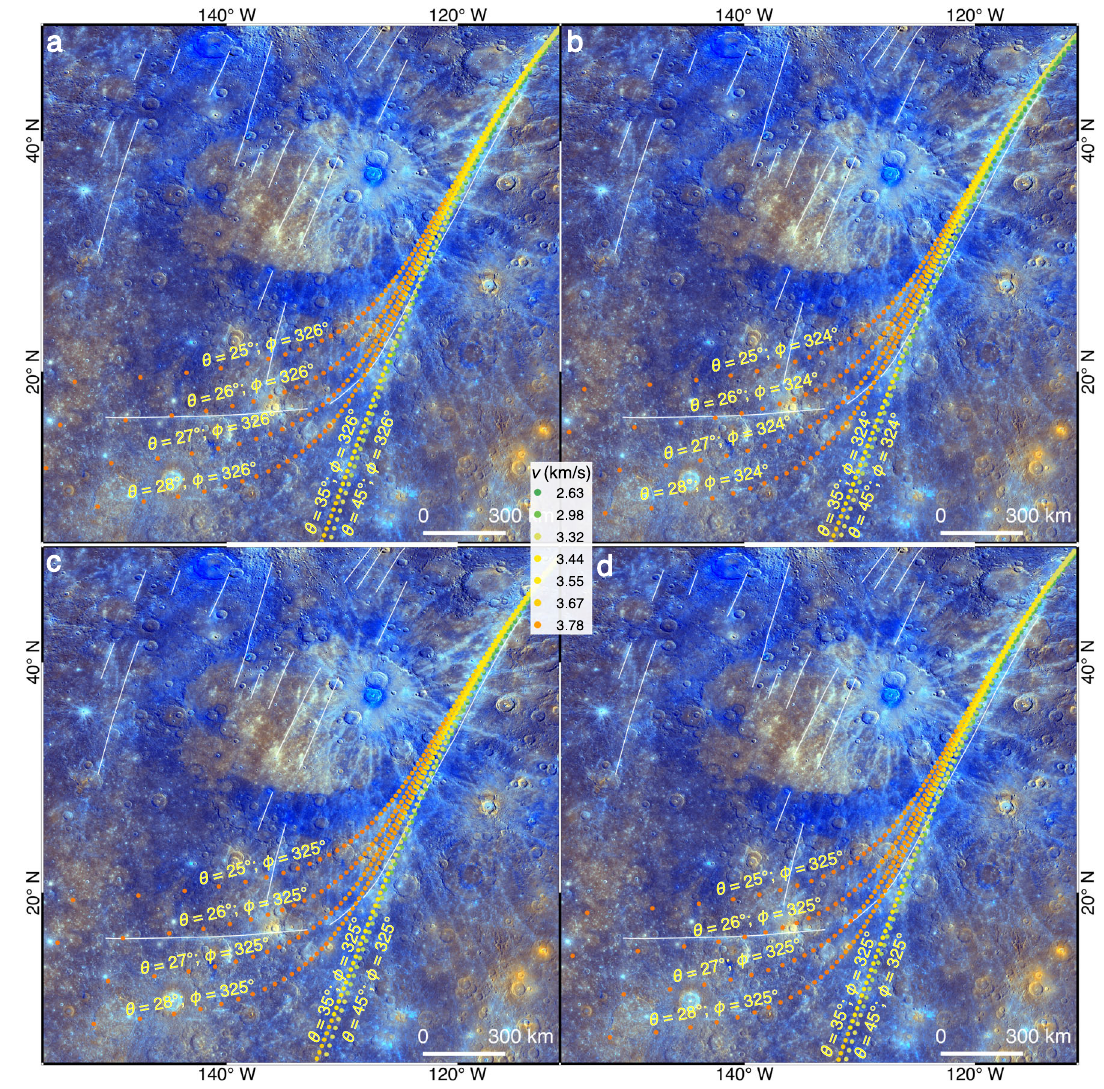
Fig.6|Ejectawithasameazimuthofexcavationcannotformtheentirecurved ray. a – d Modeled landing sites of ejecta that were excavated from the eastern, western, southern and northern rims of the transient cavity of Hokusai, respec- tively.Foreachcase,differentejectionangles( θ ) aretestedforejectawiththesame azimuth of excavation ( ϕ ). The best- fi t θ and ϕ are derived by comparing the